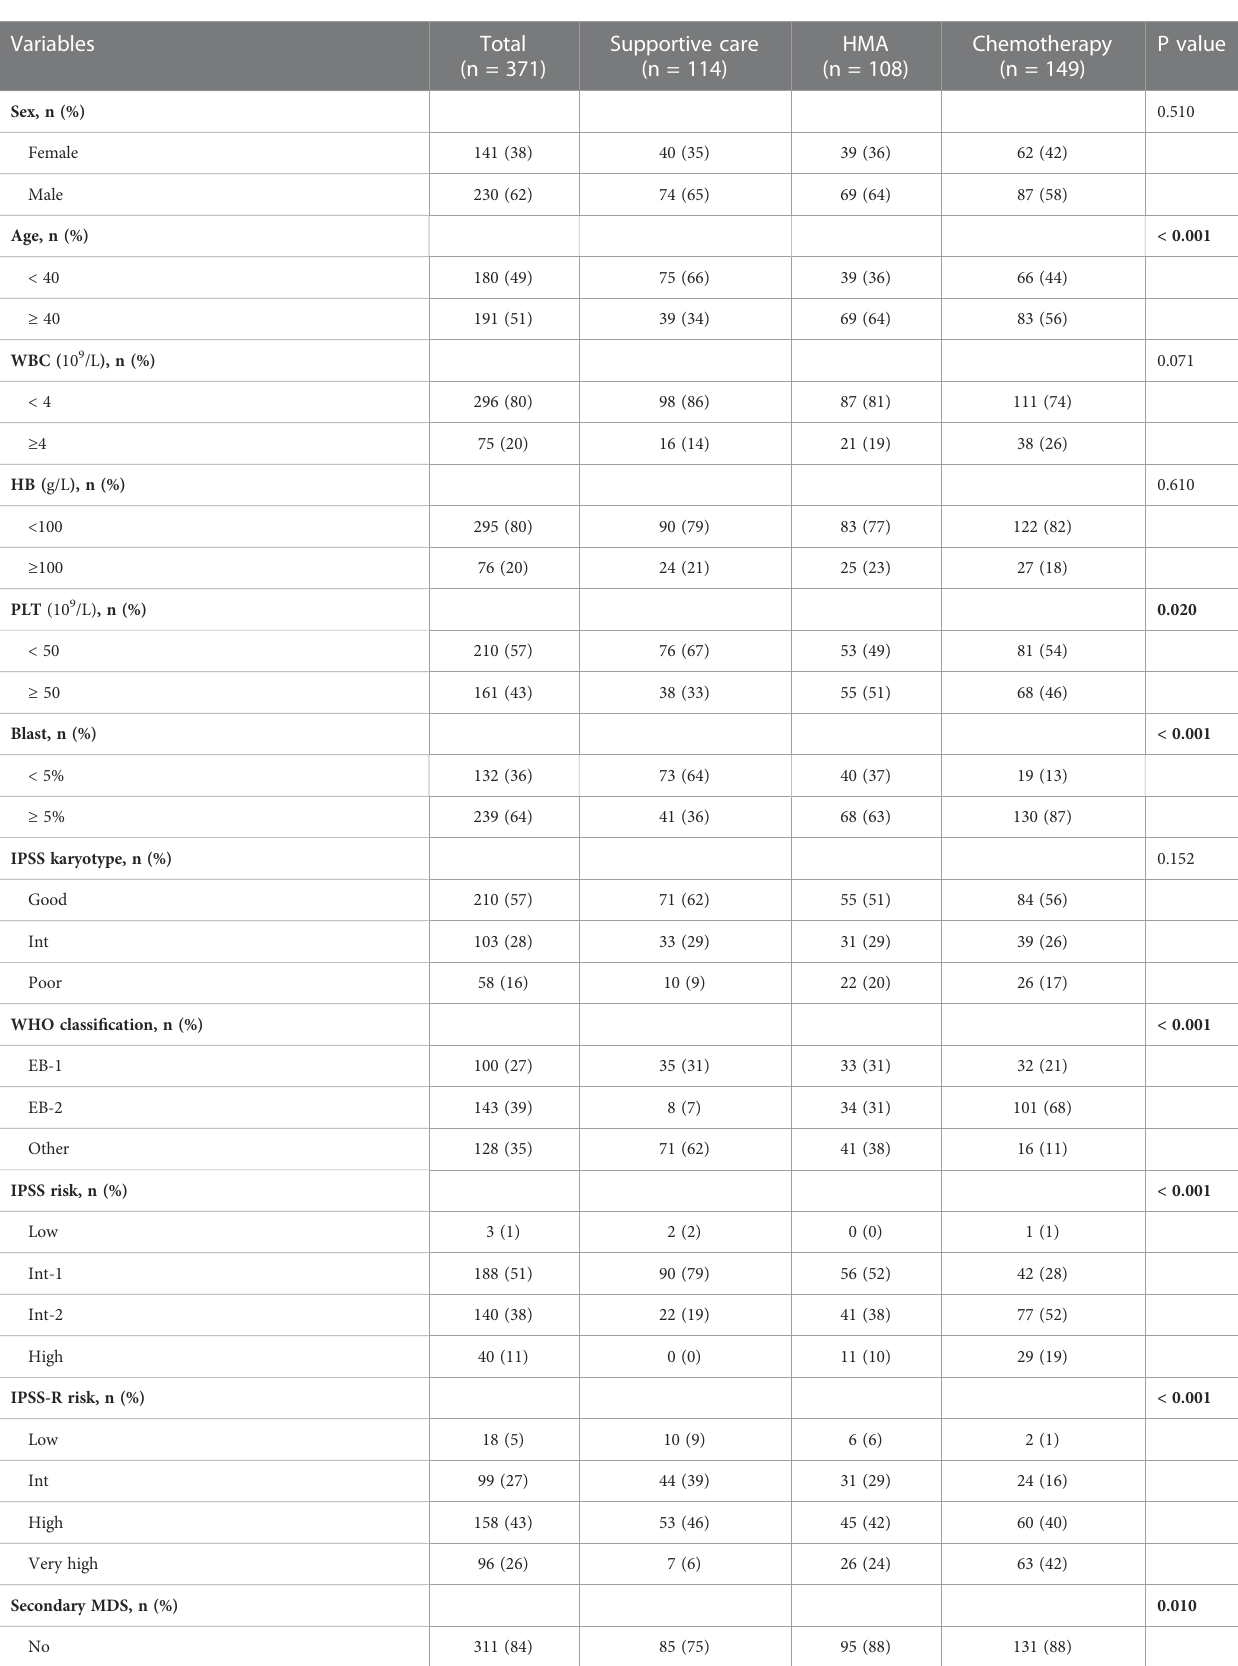
TABLE 1 Patient characteristics according to different prior-to-transplant